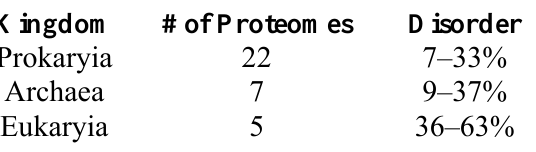
TABLE 2 . Each proteome from the three kingdoms was scanned for disorder using a PONDR predictor. The score for each proteome represents the percentage of the proteins in each